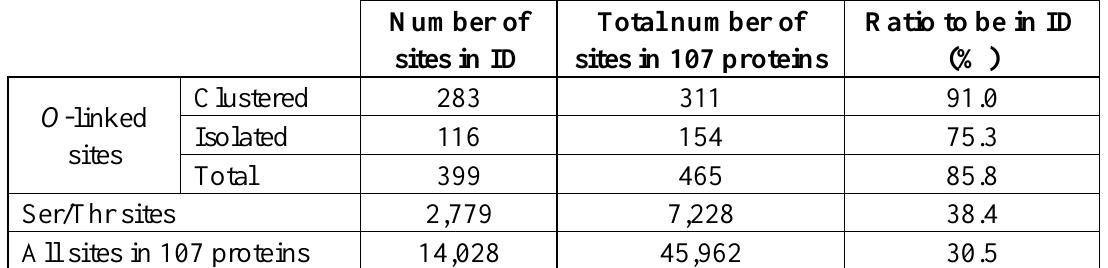
Table 1. Frequencies of occurrence of O -GalNAc glycosylations at clustered, isolated, and total glycosylation sites in ID regions. The total numbers of Ser or Thr residues, and the total numbers of amino acid residues are also shown for reference. 107 proteins were taken from UniProt 14.0, and ID regions were obtained from DICHOT